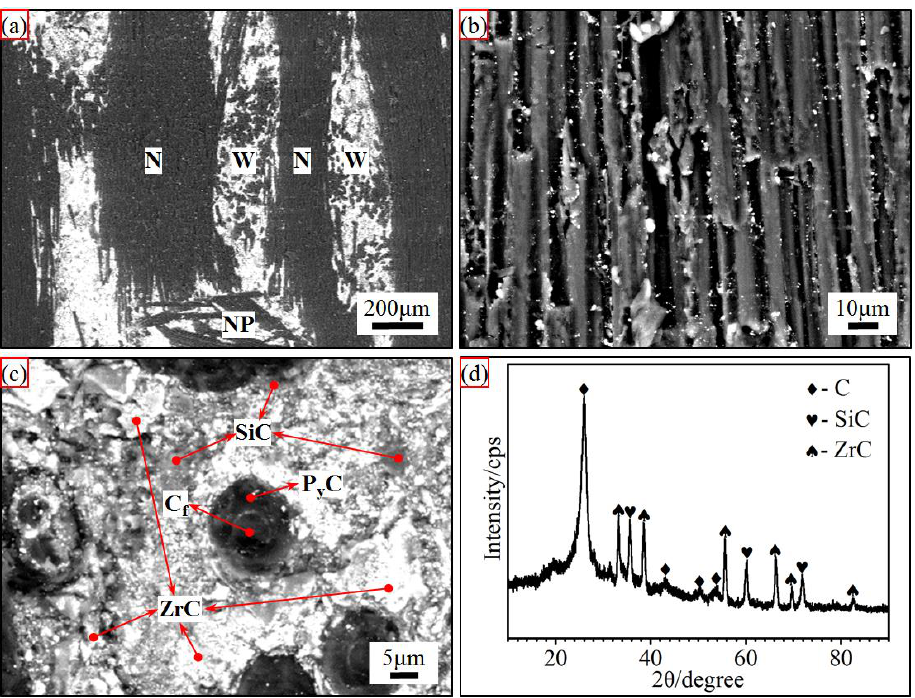
Figure 2. Microstructure and XRD pattern of the prepared C/C-SiC-ZrC composite: ( a ) low magni- fication; ( b ) non-woven layer; ( c ) web layer; and ( d ) XRD pattern. cation; ( b ) non-woven layer; ( c ) web layer; and ( d ) XRD After two different ablation processes, the macro-morphologies and ablation rates of